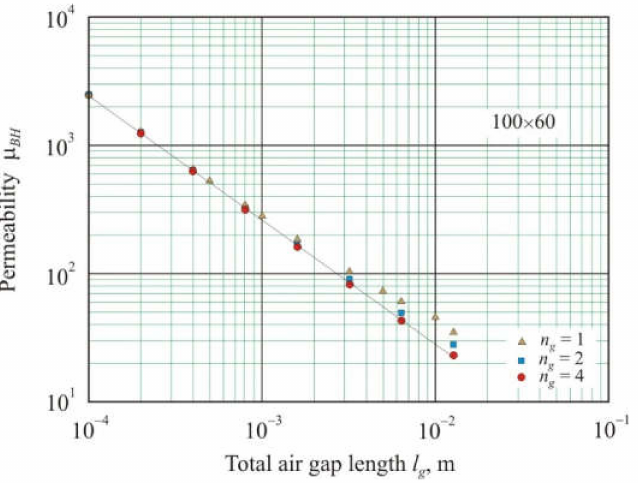
Figure 4. Relationship of effective permeability µ BH with the total length of air gaps l g in soft magnetic annuluses of 100 × 60 mm with the number of air gaps n g = 1, 2, and